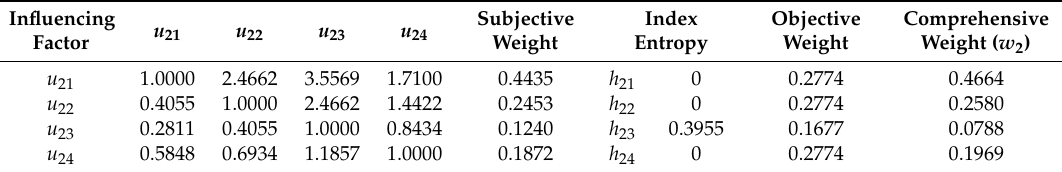
Table 16. The weights of the SCADA HMI software influencing factors.